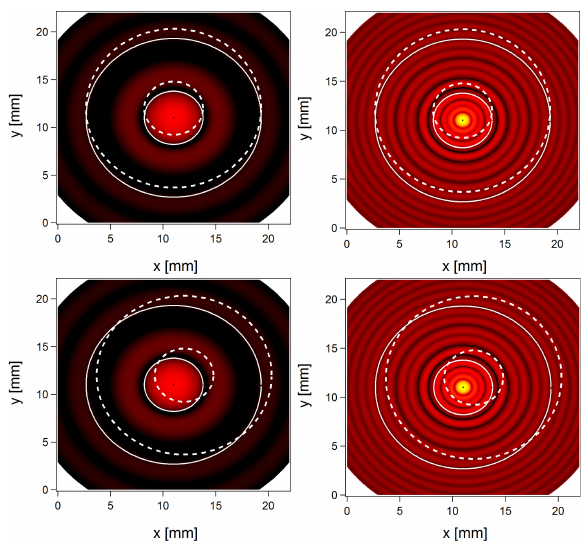
Fig. A3. Spatial distribution of scattered radiant power for 10µm (left) and 40µm (right) droplets, respectively, projected on a flat plane at 4cm distance from the droplet. The solid white circles rep- resent 4–12 ◦ symmetric collection angles. The dotted white circles represent the CDP light-collection geometry accounting for a lateral misalignment of 1mm in y (top) and 1mm in both x and y (bottom) for qualified droplets relative to the intended optical